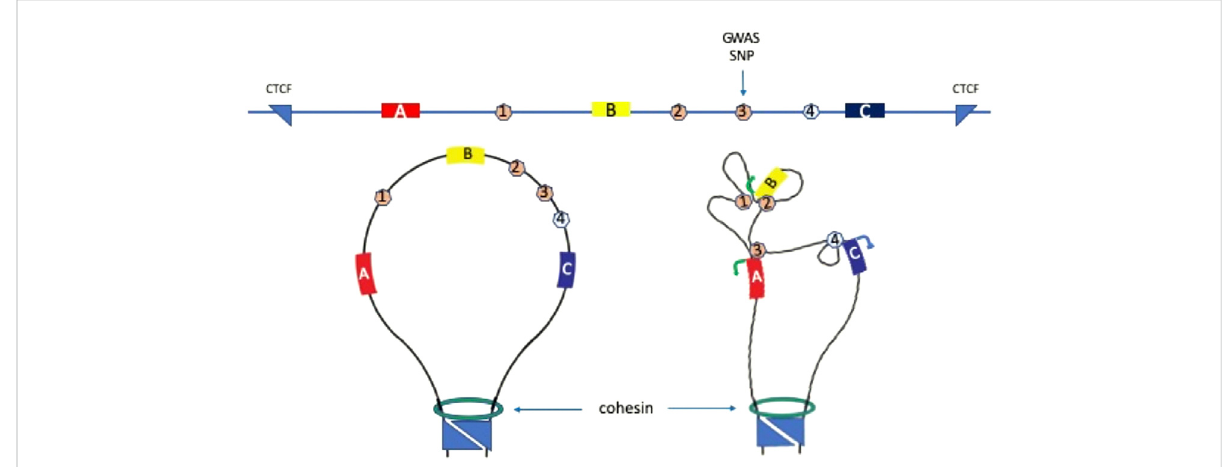
FIGURE 1 Gene regulatory elements and 3D genome conformation. Top line shows schematic of a hypothetical one megabase region of genome with three genes, (A,B, and C) ; three enhancers 1, 2, and 3; one silencer element 4; and one genome wide association study (GWAS) single nucleotide polymorphism (SNP) (vertical arrow). The locus is fl anked by convergent CTCF sites which interact and function as topologically associated domain (TAD) boundaries in cooperation with cohesin (bottom left panel). The GWAS SNP would normally be assigned to gene (B) or (C) due to proximity,howeveranalysisof3DgenomedatashowsthatSNP-bearingenhancer3contactsgeneApromotertoactivatetranscription(bottomright panel). Enhancers 1 and 2 contact gene (B) to activate transcription. The silencer element 4 contacts gene (C) to silence